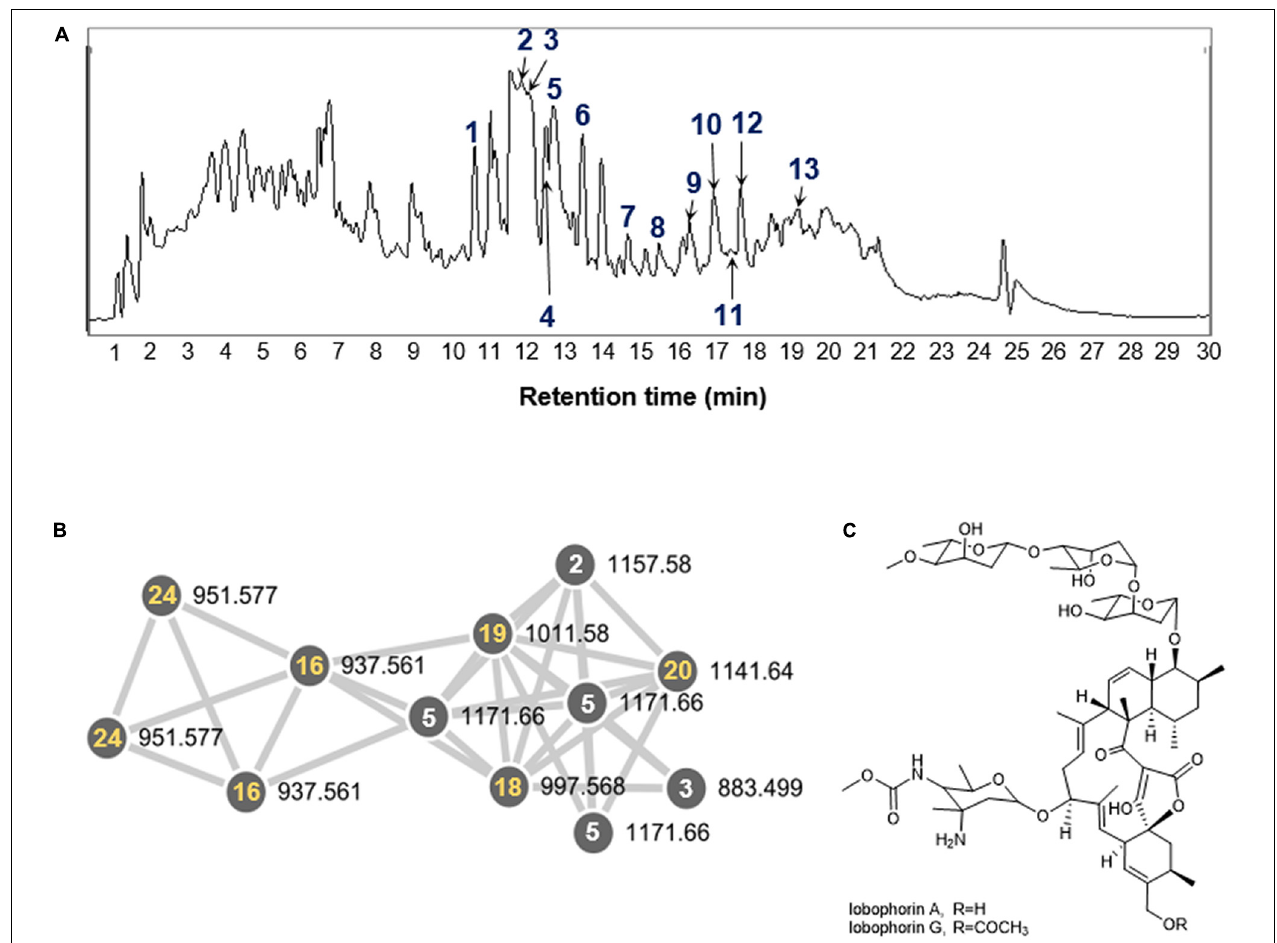
FIGURE 3 | (A) LC-MS chemical analysis of lobophorin analogs in the extract of S. olivaceus JB1 and 25 annotated compounds. Thirteen compounds ( 1 – 13 , blue ) indicate previously reported lobophorin analogs. (B) A GNPS cluster assigned to lobophorin analogs from the organic phase of the S. olivaceus JB1 liquid culture. Five specific compounds ( 16 , 18 , 19 , 20 , and 24 , yellow ) correspond to unreported lobophorin analogs that clustered with reported lobophorin analogs in GNPS (selected). (C) The chemical structures of lobophorin A and G ( 2 and 6